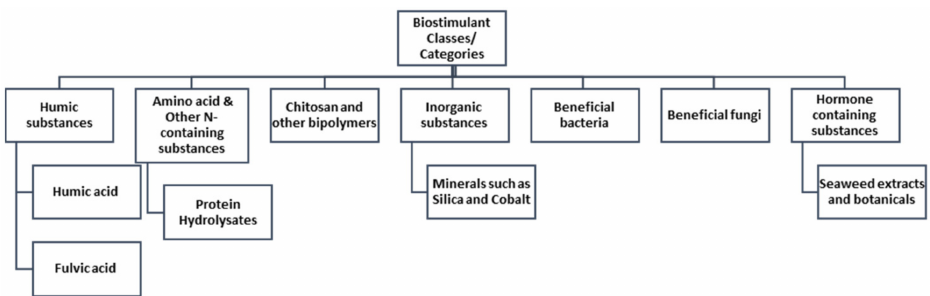
Figure 1. Different classes of biostimulants adapted from